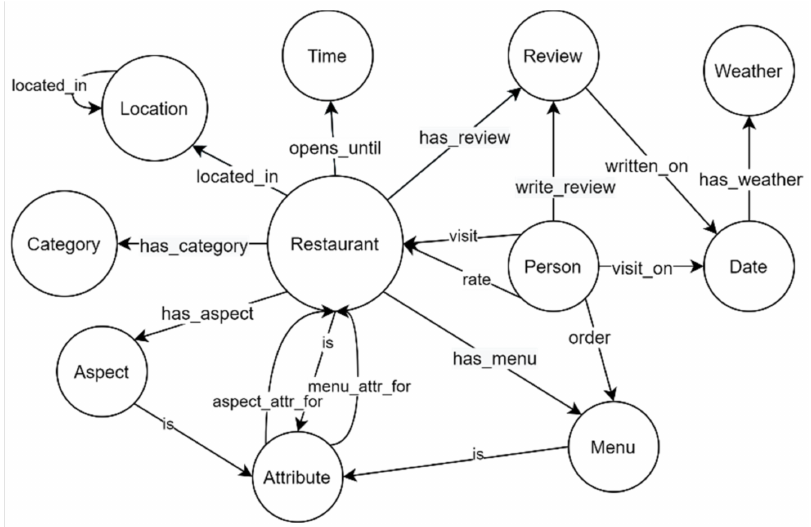
Figure 2. Conceptual graph schema (ontology) for restaurant domain knowledge